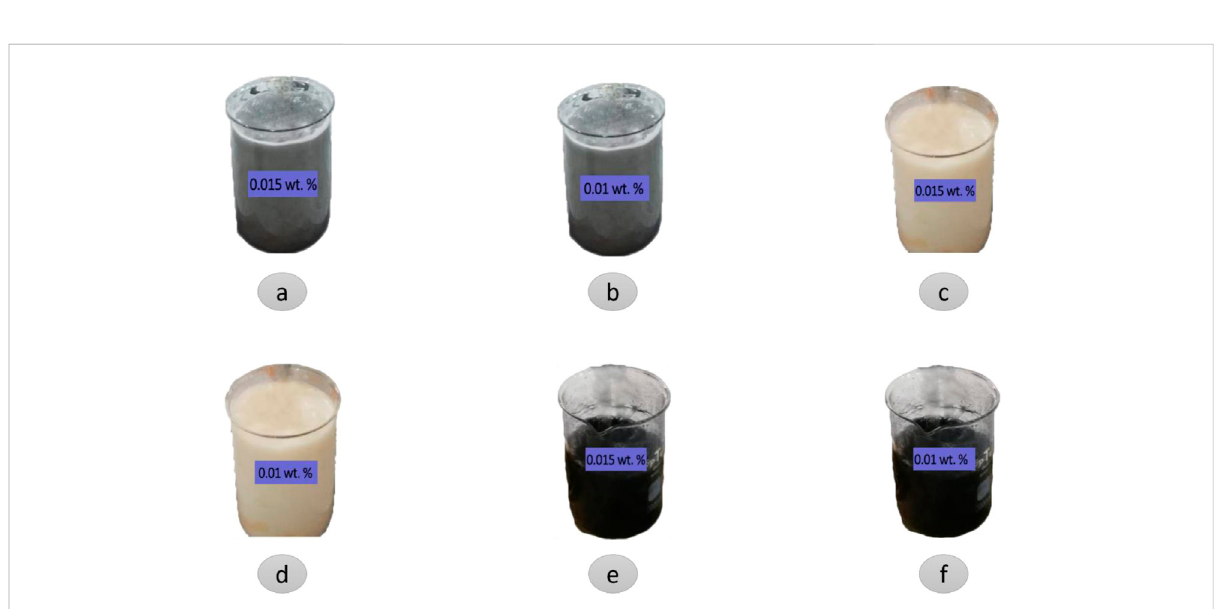
FIGURE 4 PreparedNFsandhybridNFs: (A) MgO+CB/water, (B) MgO+CB/water, (C) SiO 2 /water+EG, (D) SiO 2 /water+EG, (E) CB+GNPs,and (F)